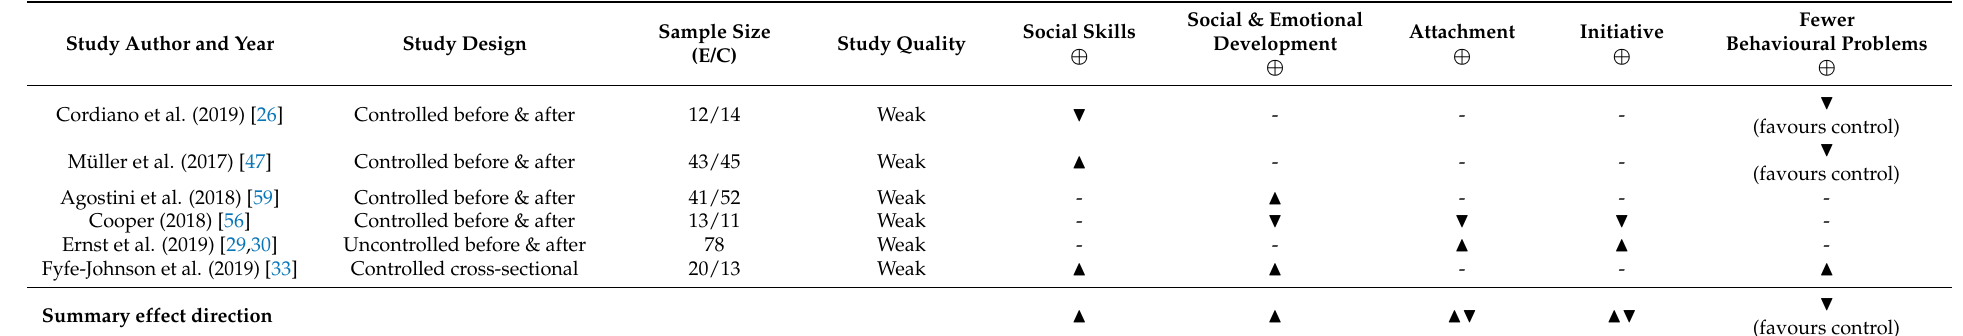
Table 2. Effect direction plot for nature-based ECE vs. traditional ECE on social and emotional outcomes.